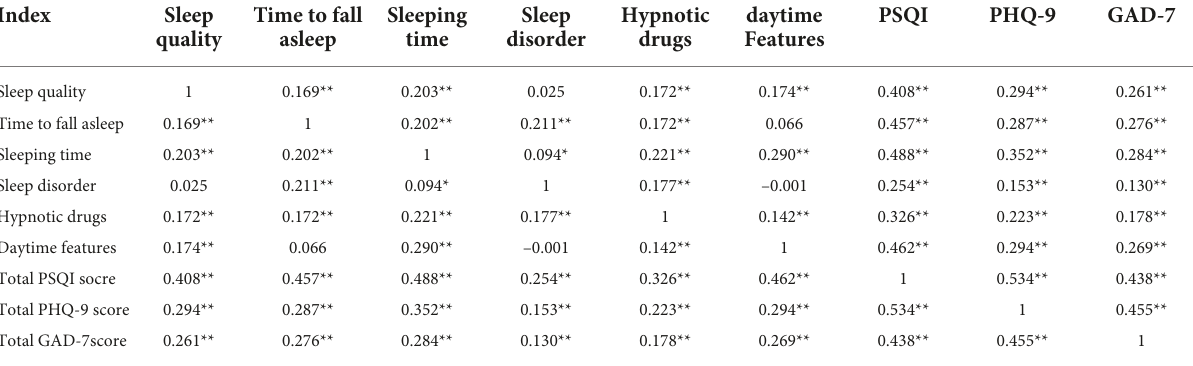
TABLE 4 Correlation analysis of sleep quality, depression and anxiety